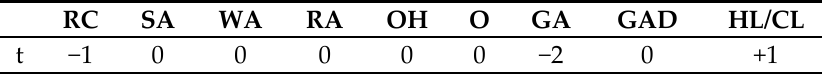
Figure 8. FIR mask obtained for heating load (HL) and cooling load (CL) models.